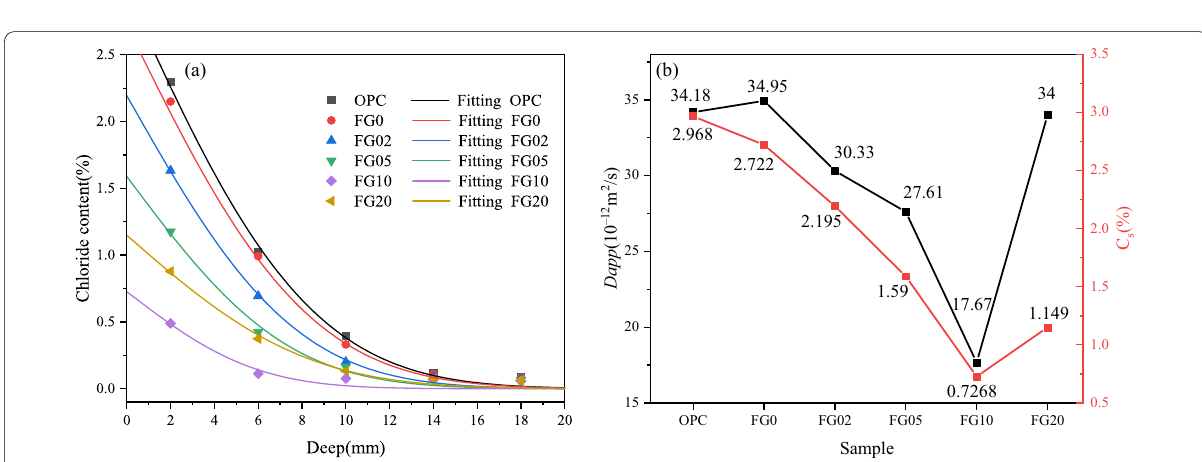
Fig. 11 Chloride diffusion of 3DG-fly ash cement. a The chloride concentration and best fit curves; b The chloride diffusion coefficient and surface chloride